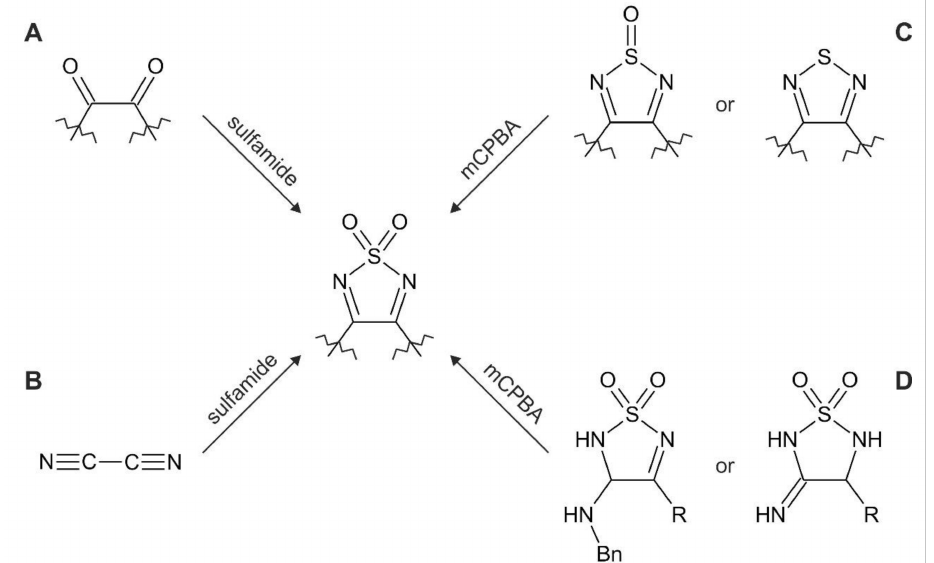
Figure 4. Summary of the synthetic strategies toward 1,2,5-thiadiazole 1,1-dioxides: condensation of 1,2-diketones ( A ) or cyanogen ( B ) with sulfamide or oxidation of the pre-existing heterocyclic scaffolds of 1,2,5-thiadiazoles or 1,2,5-thiadiazole 1-oxides ( C ) or 1,2,5-thiadiazolidines 1,1-dioxides ( D ) using mCPBA. Table 3. Summary of the synthetic strategies toward 1,2,5-thiadiazole 1,1-dioxides as depicted in Figure 4. Synthesis